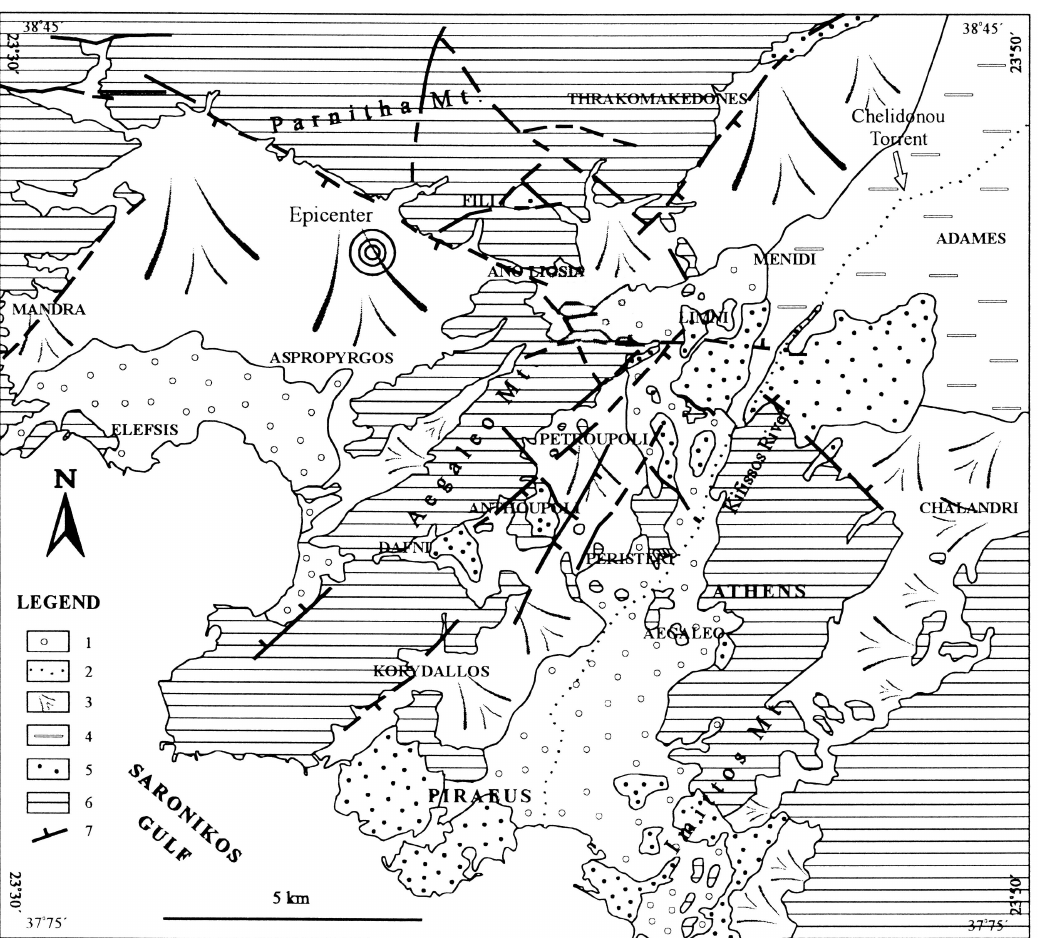
Figure 2. Major tectonic structures and geological map of the study area, reproduced from Lekkas [17]. The epicenter of the 1999 Athens earthquake is marked. 1. Alluvials; 2. fluvial deposits and